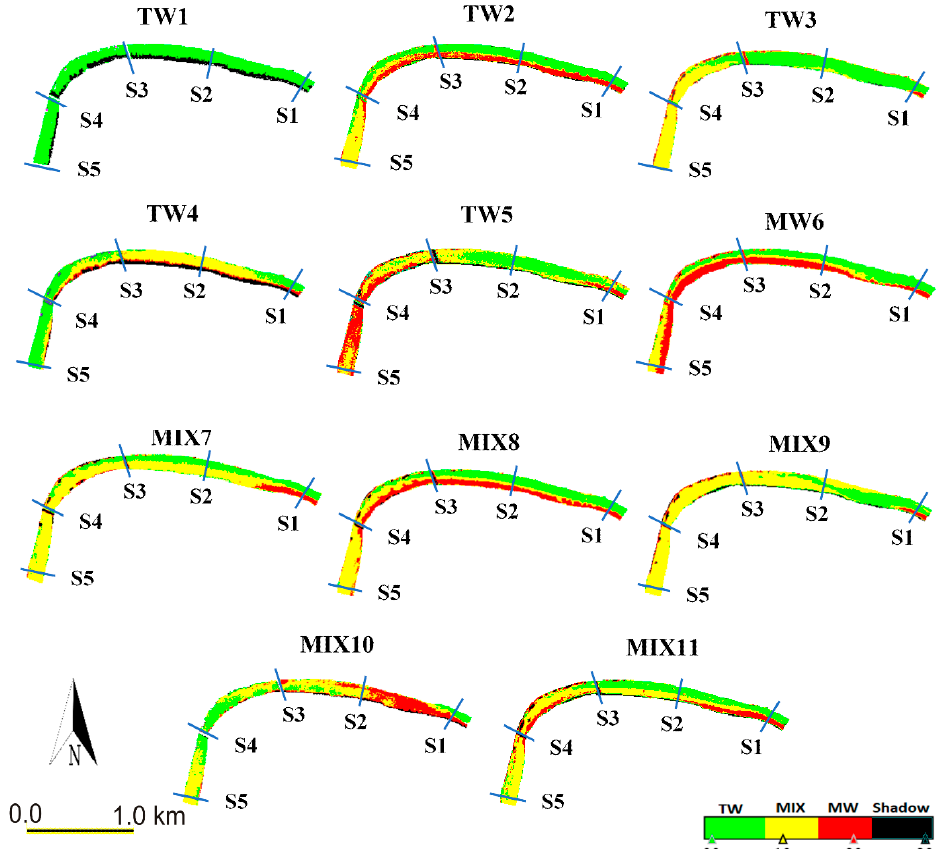
Figure 8. Examples of the eleven identified mixing patterns.